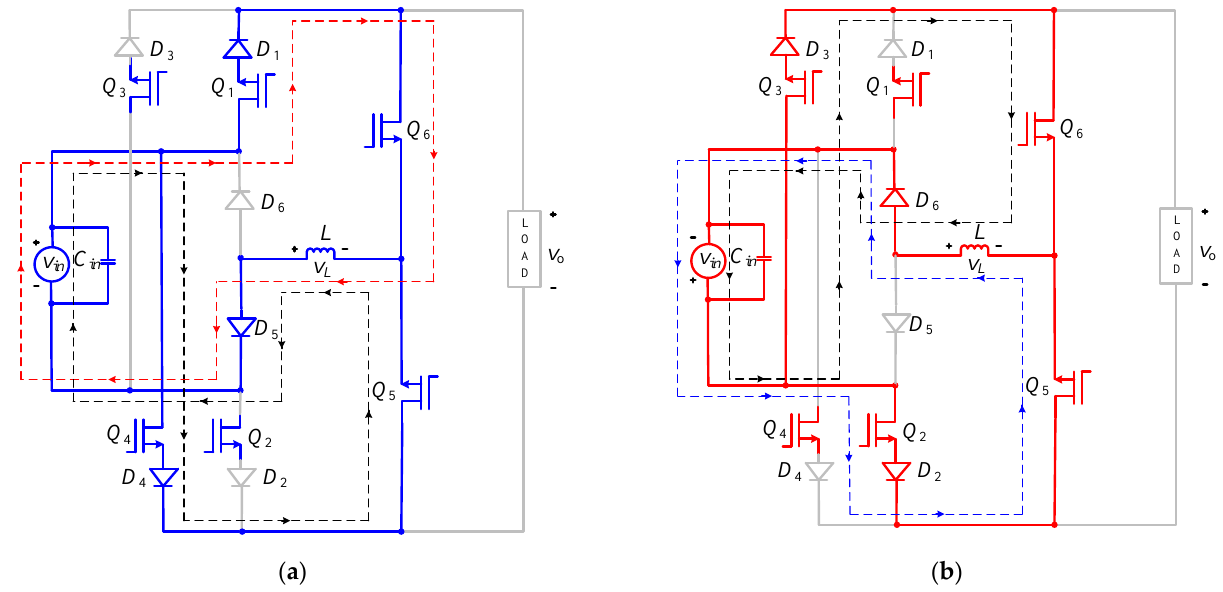
Figure 3. Currents loops during shoot-through operation for ( a ) positive input and ( b ) negative input. The cathodes of the diodes “ D 1 ”, “ D 3 ” and “ D 2 ”, “ D 4 ” are connected to the same node